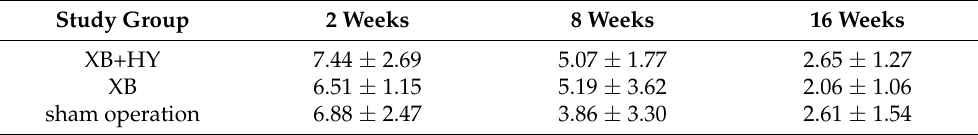
Table 8. Vascularization within the calvaria defect sites of the different study groups (in percent (%)). Study